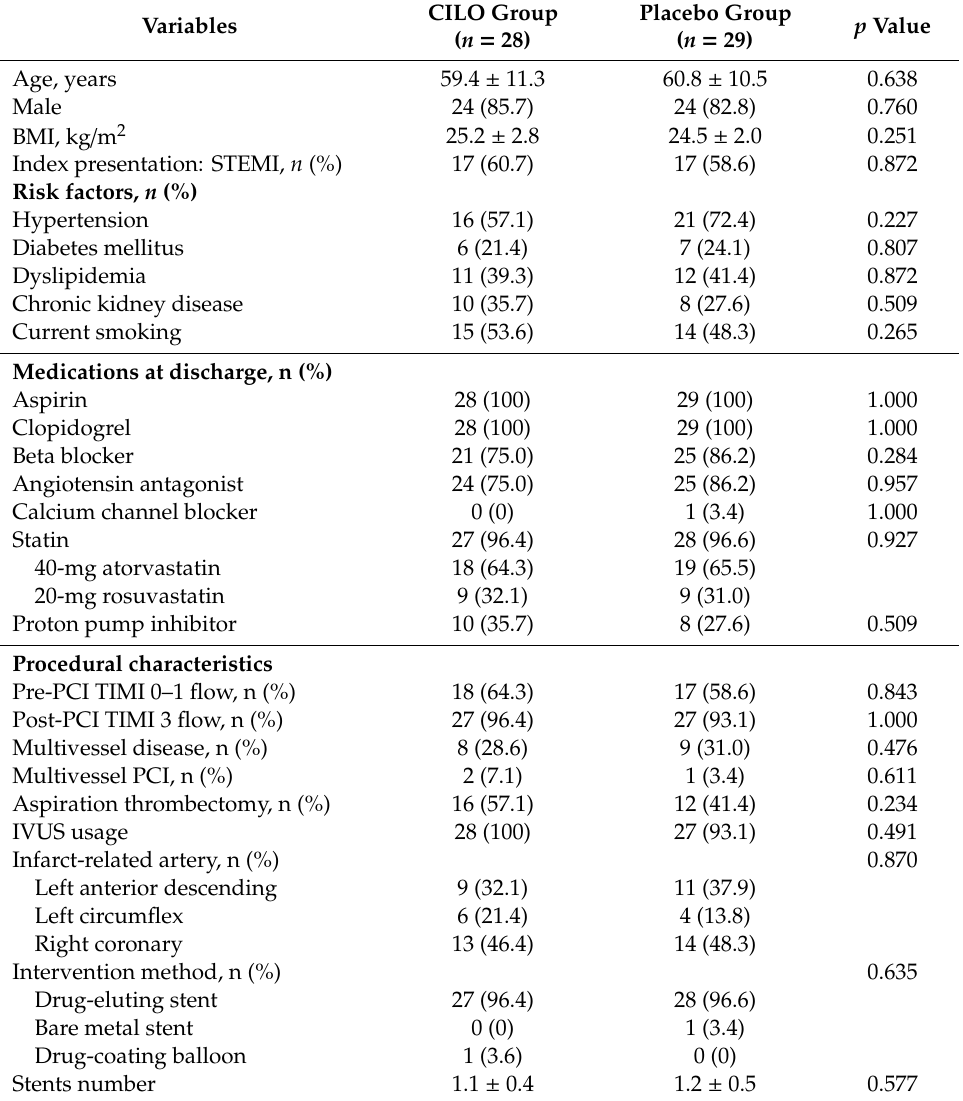
Table 1. Baseline demographic and procedural